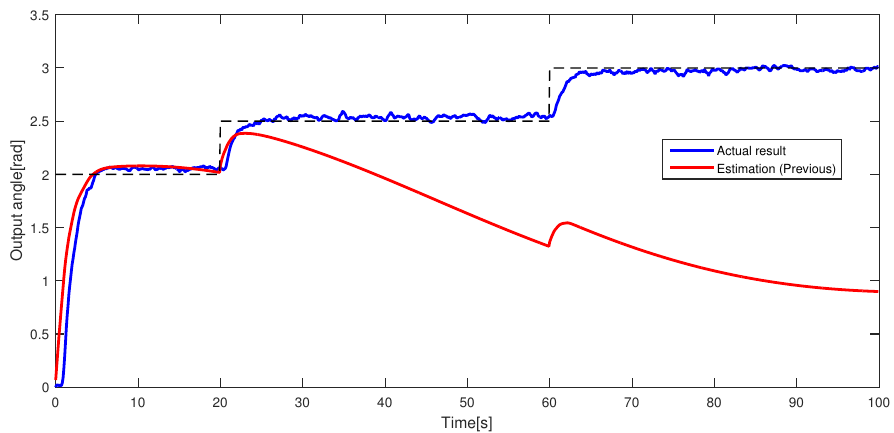
Figure 16. The result of the previous method.